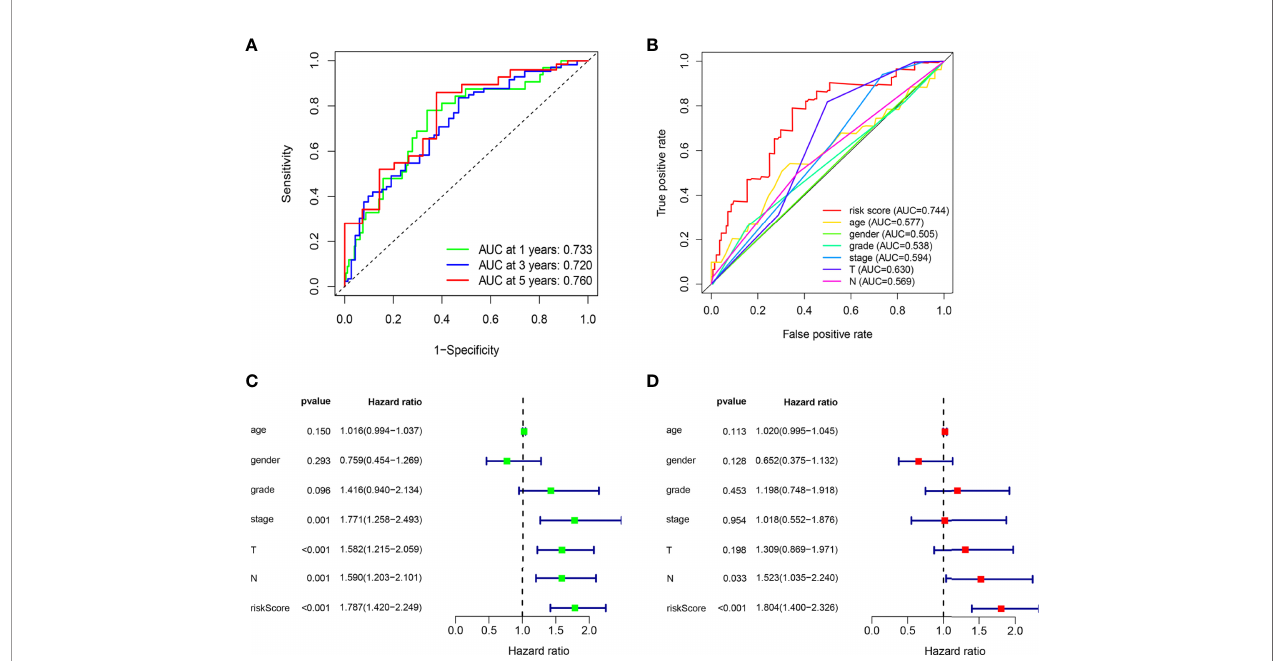
FIGURE 3 | The ARG prognostic signature shows good predictive performance in the internal training dataset. (A) The ROC curves of the ARG model for the 1-, 3-, and 5-year survival rates, and the corresponding AUC was 0.733, 0.720, and 0.760. (B) The AUC value of the risk score (0.744) showed superior predictive performance than age (0.577), gender (0.505), grade (0.538), stage (0.594), T stage (0.630), and N stage (0.569). (C) The risk score was a signi fi cant dangerous factor to in fl uence the OS with HR = 1.787 (95% CI = 1.420 – 2.249, p <0.001). Other clinical factors such as stage with HR = 1.771 (95% CI = 1.258 – 2.439, p =